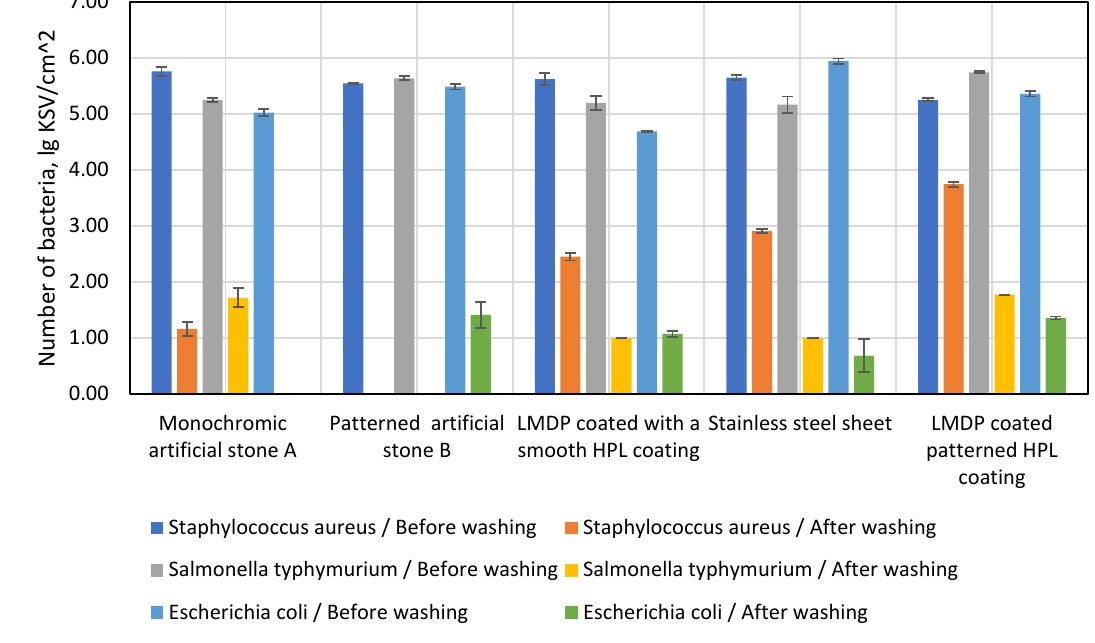
Figure 15. The number of bacteria on the surface of each material. Patterned and monochrome artificial stone had 5.77/5.55 lg CFU/cm 2 (number of colonies forming units per square centimetre) before washing, and after washing this number dropped to 1.17/0 lg CFU/cm 2 . It was observed that no bacteria per square centimetre were present in the artificially cast monochrome stone after washing. The test of artificial cast stone was followed by a test of LMDP coated with a smooth HPL coating, which had 5.63 lg CFU/cm 2 before and 2.46 lg CFU/cm 2 after washing. In a stainless-steel plate experiment, it was observed that the Staphylococcus aureus bacteria survived well after washing (2.92 lg CFU/cm 2 ), although it had fewer bacteria than the working pre-wash stone (5.66 lg CFU/cm 2 ). The worst results in the study with this bacterium were shown by the LMDP-coated corrugated HPL plate, which had 5.26 lg CFU/cm 2 before washing and 3.75 lg CFU/cm 2 after